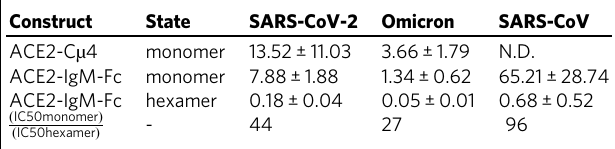
Table 1 Virus neutralization data for the constructs — Mean IC50s (nM) ±standard deviation ( n = 6). The values are from the fi ts to the data in Fig.